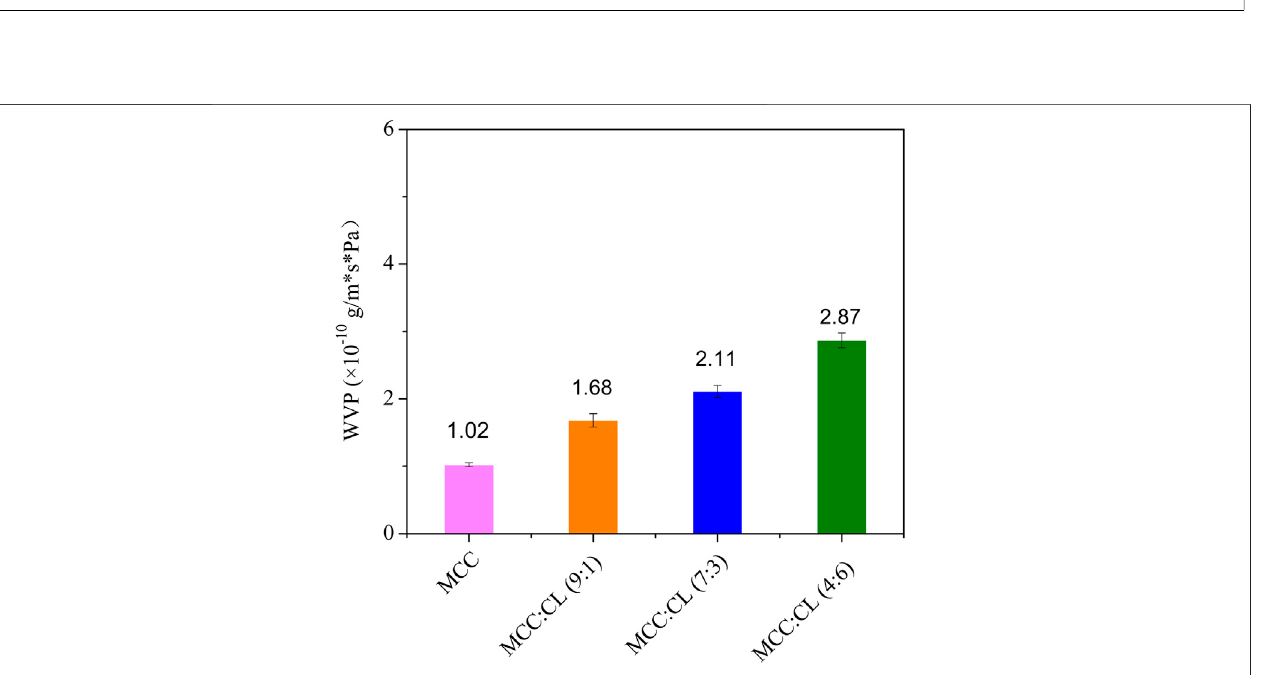
FIGURE 7 | WVP of the MCC fi lm and MCC:CL biocomposite fi lms.